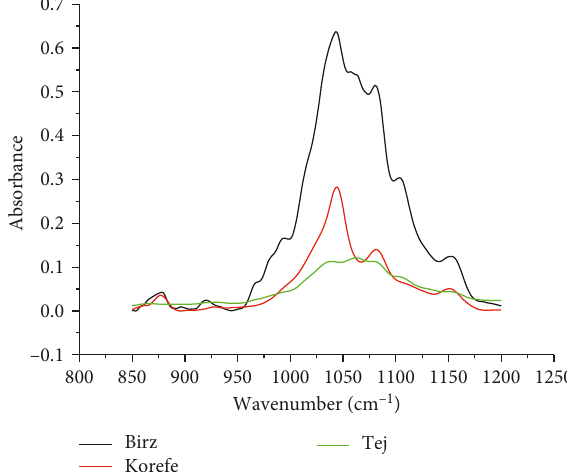
Figure 2: MIR spectra of selected fermented alcoholic